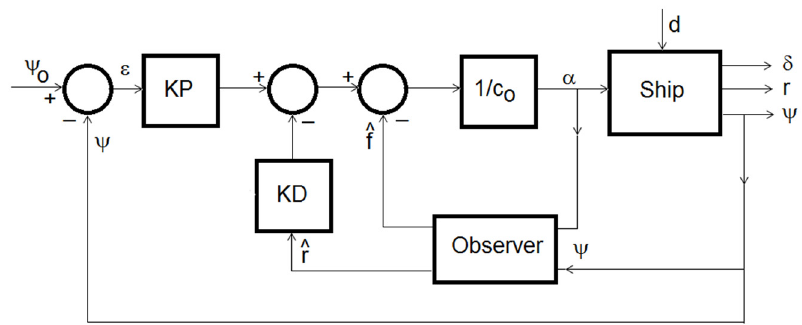
Figure 1. Block diagram of ADRC heading angle control system. The following symbols are used: ψ — heading angle, ε — error signal, α — steering gear command, δ — rudder deflection angle, r — angular speed and d — disturbances.